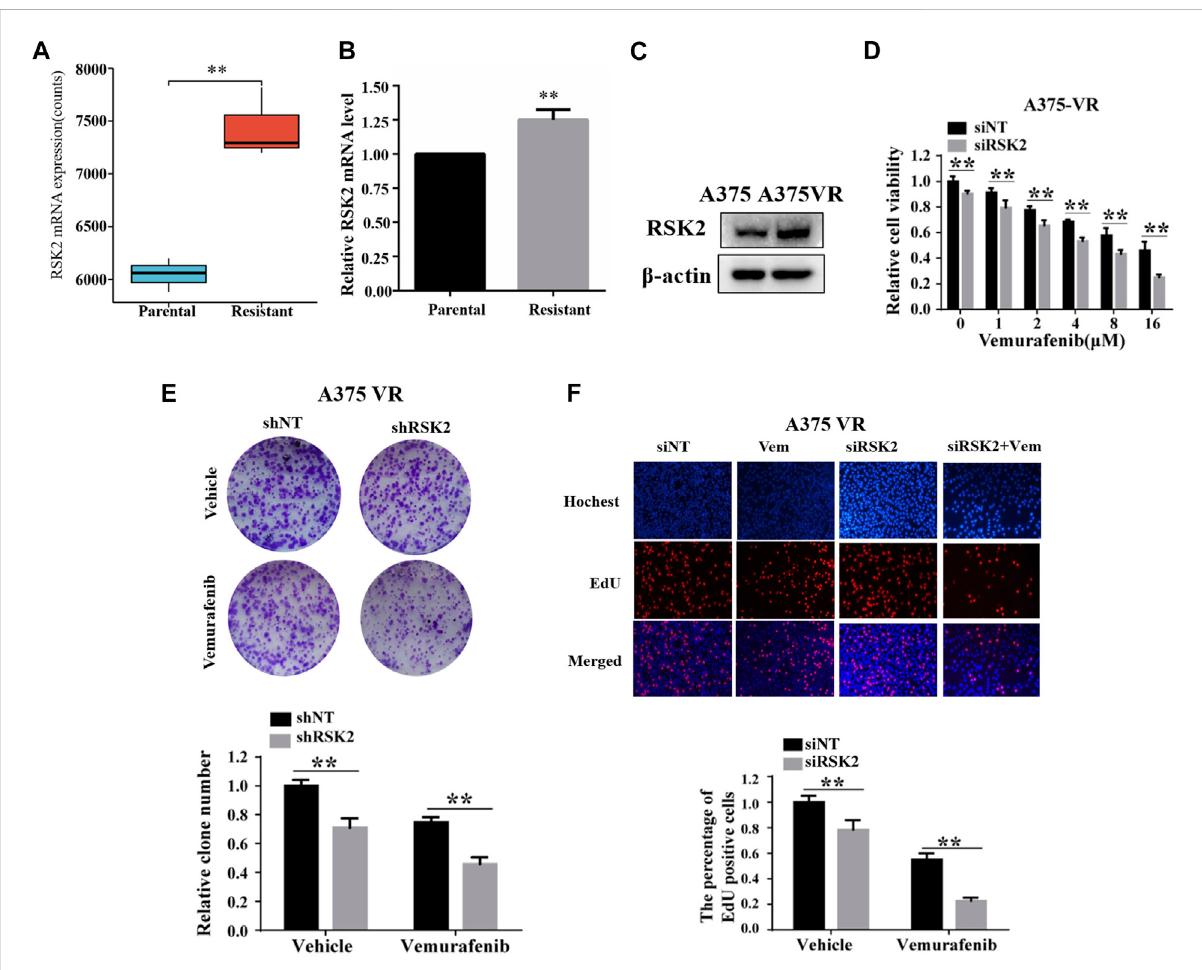
RSK2 promotesmelanomacell vemurafenib resistances. (A) RSK2 mRNA expression levels in A375 and A375-VR cells (GSE99923). (B) RT-qPCR was used to measure RSK2 mRNA expression in A375 parental cells and A375 vemurafenib resistant cells. (C) The protein levels of RSK2 were detected in A375 or A375-VR cells by Western blot. (D) Cell viability of siNT or siRSK2-transfected A375-VR cells under increasing dose of vemurafenib treatment was assessed by CCK-8 assay. (E) The cell proliferation of shNT or shRSK2-transfected A375-VR cells with